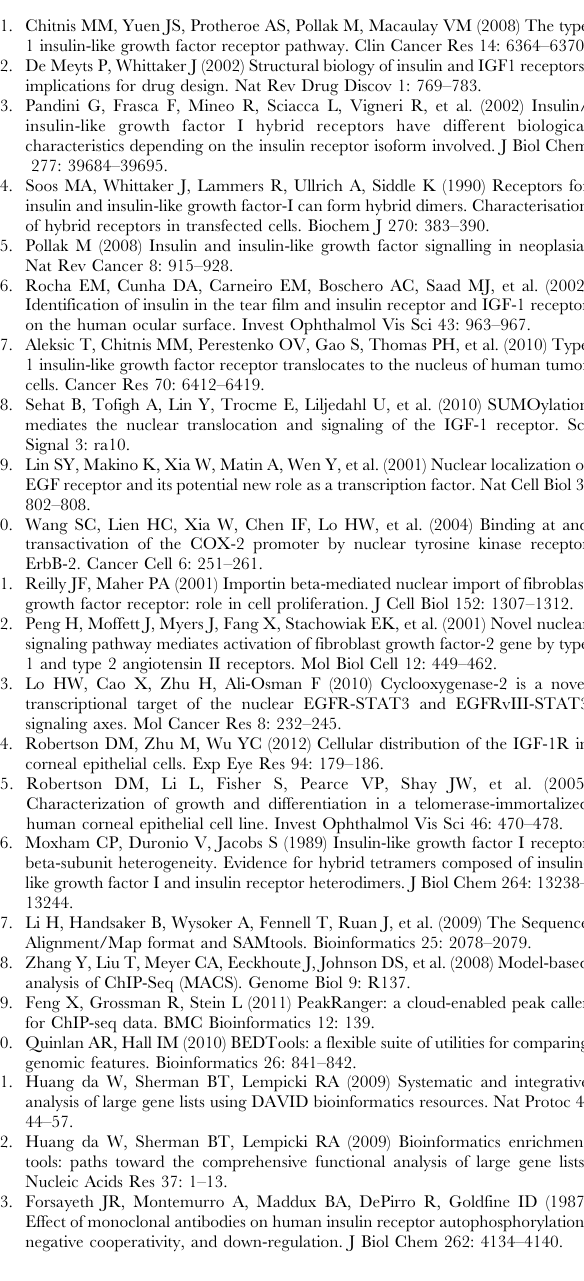
Figure S6 The distribution of INSR-enriched MACS peaks over chromosome